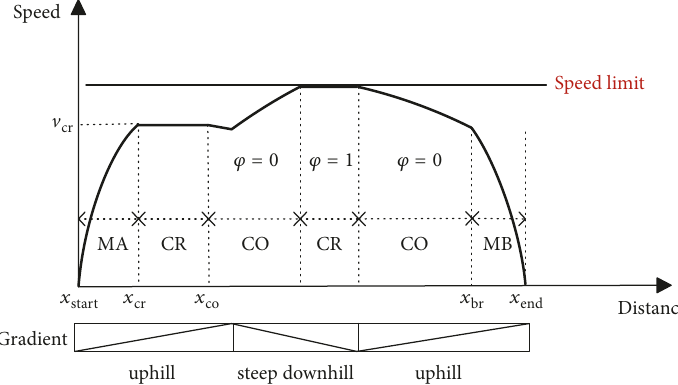
Figure 2: Improved energy-efficient train control